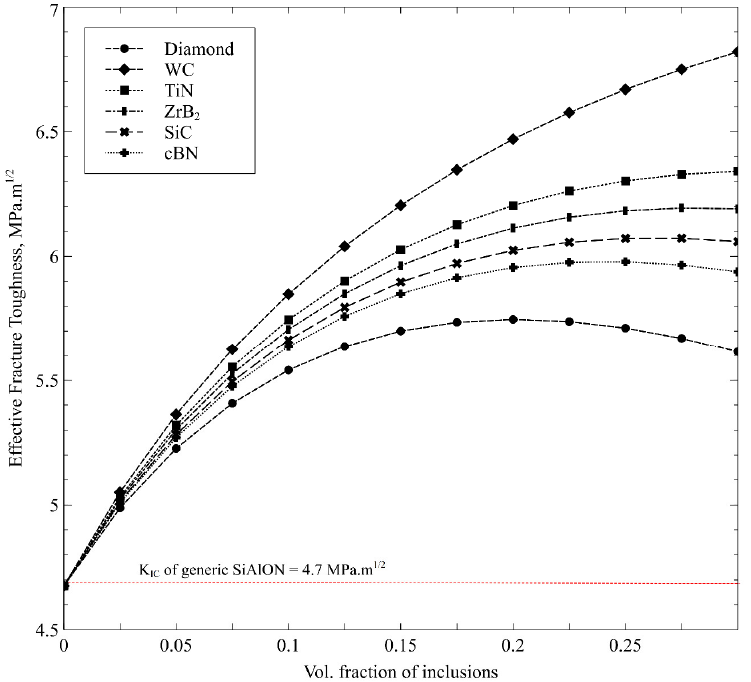
Figure 5. Predicted effective fracture toughness of Ca- α -SiAlON composites as a function of volume content of potential ceramic